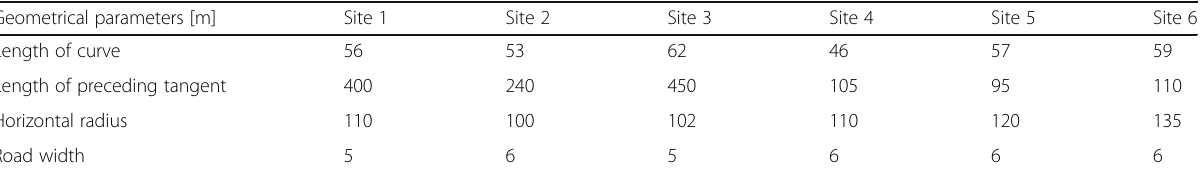
Table 1 Geometrical parameters of the studied sites